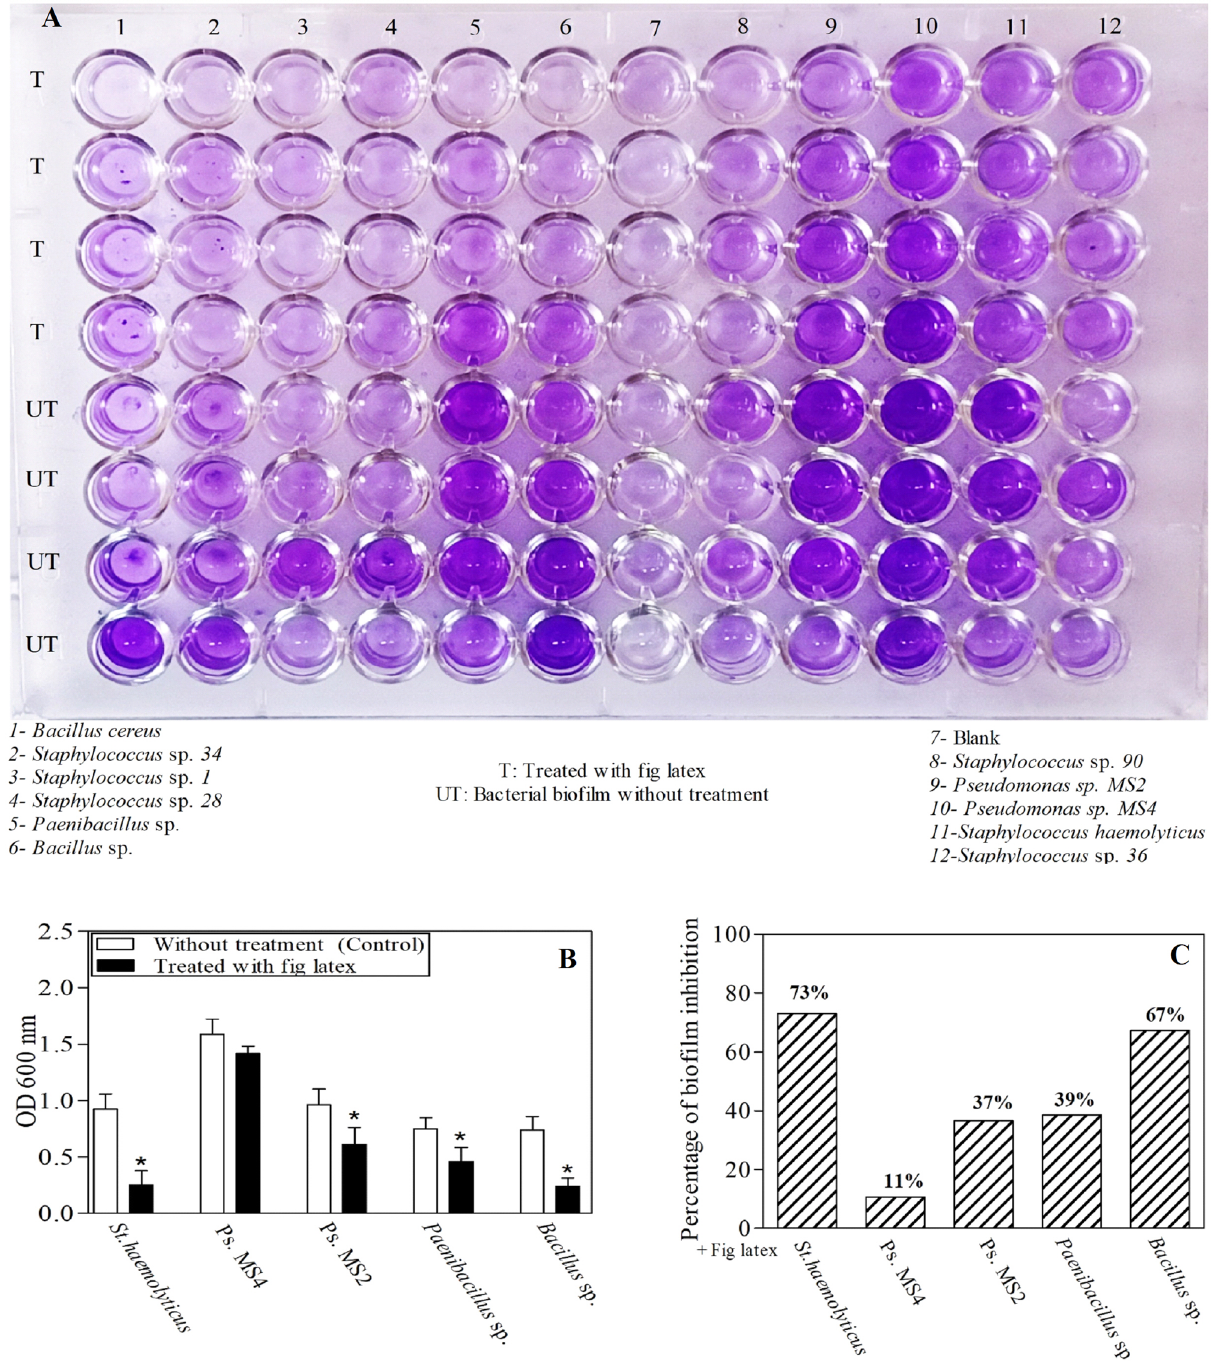
Figure 4. The impact of fig latex on bacterial biofilm using a microtiter plate biofilm assay against five pathogenic bacterial isolates from diabetic foot ulcers. ( A ) Microtiter plate showing the differences in the color intensity; ( B ) Quantitative determination of the optical density of the biofilm from the isolated bacteria as control (open bars) and after treatment with latex (closed bars); ( C ) Percentage of the antibiofilm activity of fig latex against the bacterial isolates ( St. haemolyticus, Ps. MS2, Ps. MS4, Bacillus sp. and Paenibacillus sp . ) (PECAM-1) as a marker of vascularization in wounded skin tissues. The diabetic animal group showed a decrease in the expression of PECAM-1 from Day 3 to 15 post-wounding, with a mild positive reaction compared to those found in the control animals, which exhibited a strong positive reaction of PECAM-1 expression. Amazingly, the wounded tissues of diabetic skin mice treated with fig latex exhibited a moderate reaction compared to the control group. Using ImageJ software, accumulated data for PECAM-1 expression were quantified and are pre- sented in Fig. 8F. The diabetic mice showed a significant decrease in the expression levels of PECAM-1 from Day